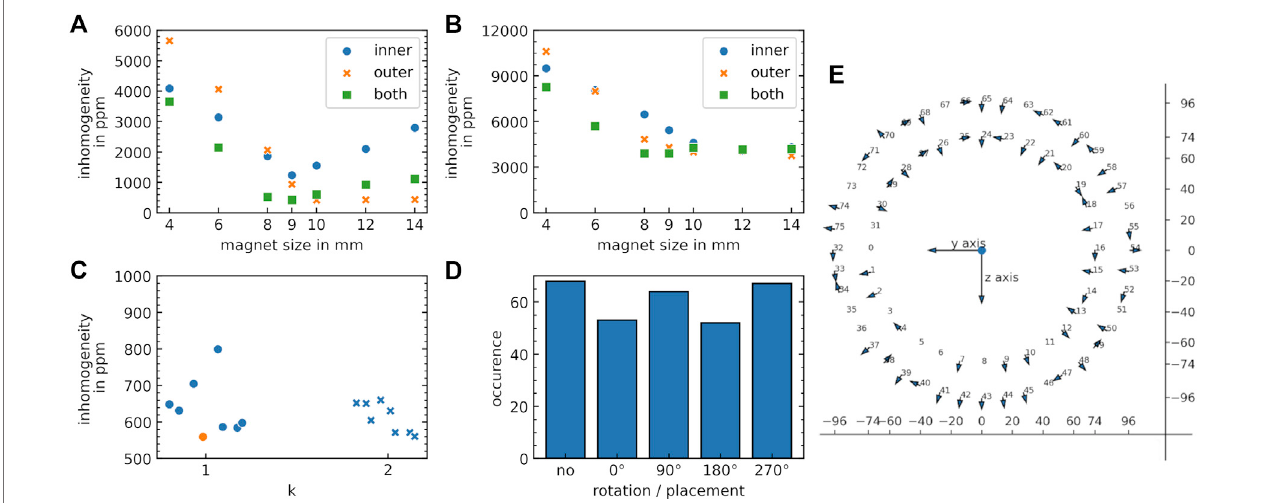
FIGURE 6 | Results calculated by the shimming algorithms. (A) Homogeneities achieved for different shim magnet sizes based on the simulated magnetic fi eld distribution(FEM)forcon fi gurationsinner (bluecircles),outer(orangecrosses),both(greenboxes) for (A) the2Dtargetsliceof4 cmindiameterand (B) the3Dsphereof 4 cm in diameter. (C) Calculated B 0 homogeneities for a radial (k (cid:1) 1) and Halbach (k (cid:1) 2) base symmetry of the shim. The best calculation is indicated in orange. (D) Occurrenceoftherotationalorientationandplacementforthebestdesignidenti fi edinC. (E) Examplecon fi gurationofshimmagnetplacementinoneshimring.The arrows indicate the orientations of the magnetic moments at the respective positions of the shim